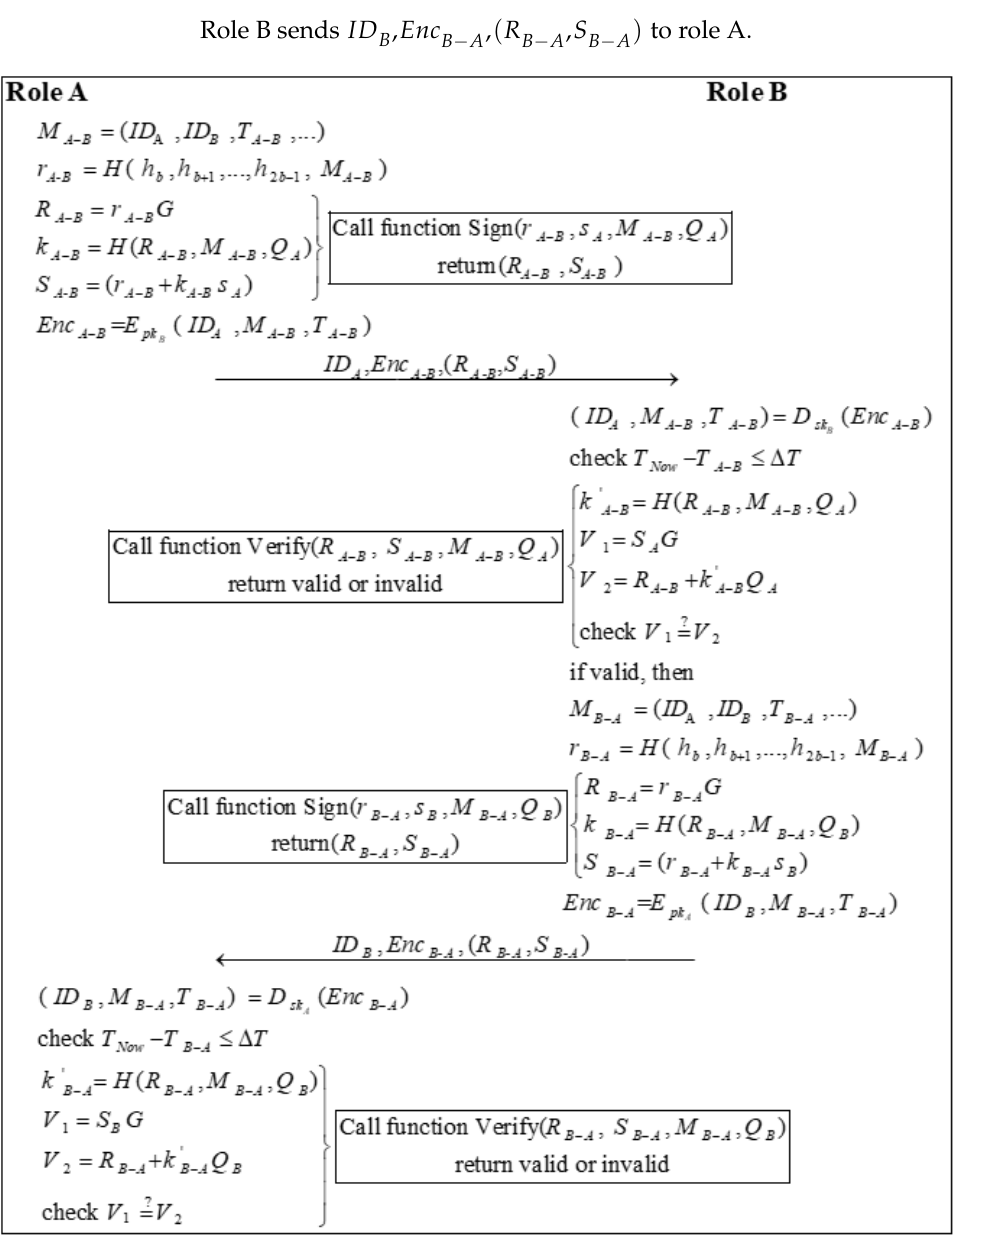
Figure 5. The process of the authentication phase. Algorithm 2: The process of the EdDSA signature between role A and role B fuction Sign(String ,String ,String